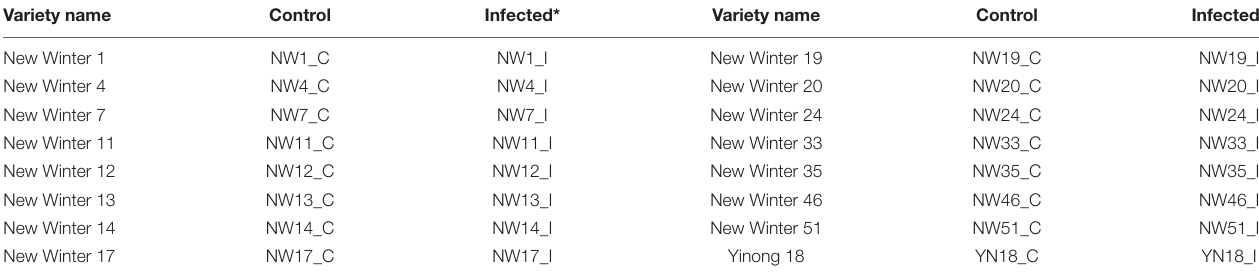
TABLE 1A | List of the varieties used in this study.